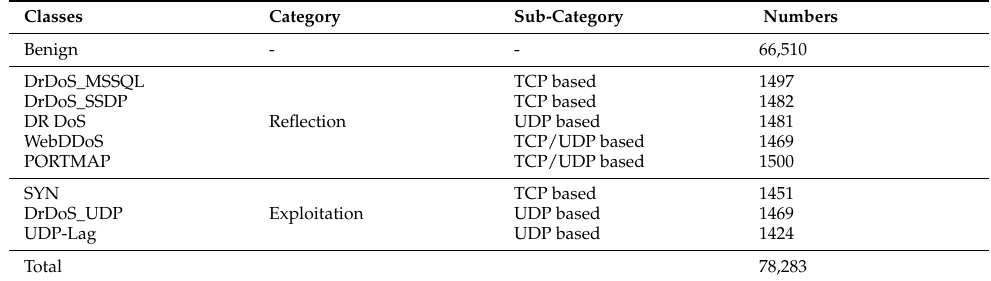
Table 2. Data set description. DoS: denial of service; DDoS: distributed denial of service; TCP: transmission control protocol; UDP: user datagram